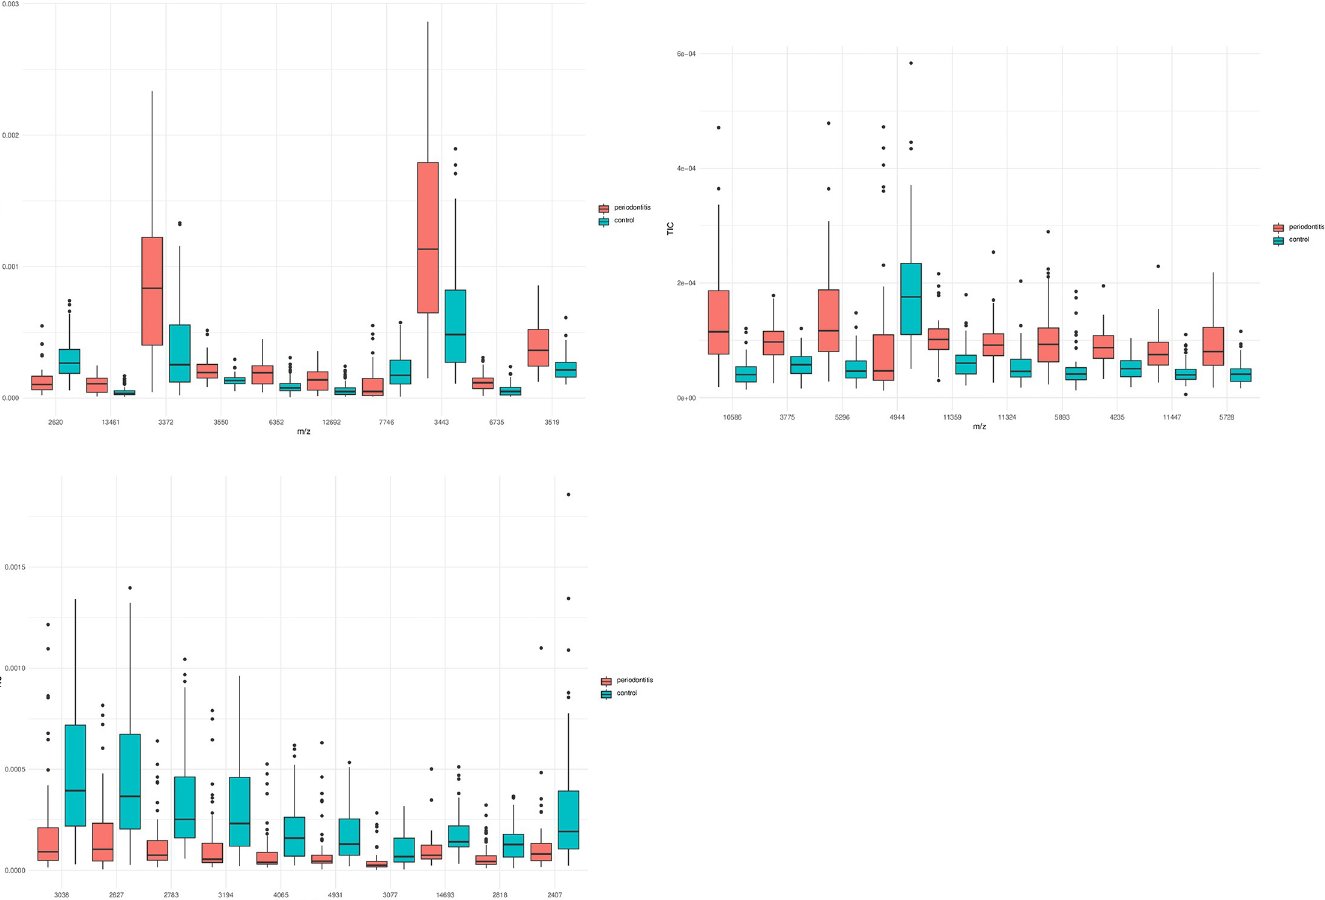
Fig 1. Box plots of the 10 top ranking peaks differentially expressed between the periodontitis and the control groups (a. saliva, b. GCF, c. dental plaque). Most of the differentially expressed peaks had higher levels of intensities in the periodontitis group in saliva and GCF, while all 10 top ranking peaks were found to be decreased in dental plaque from the periodontitis